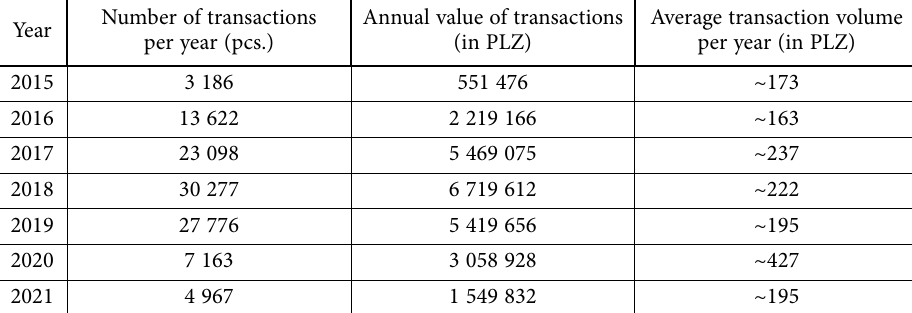
Table 3. Average transaction volume per year (in PLZ) (source: own